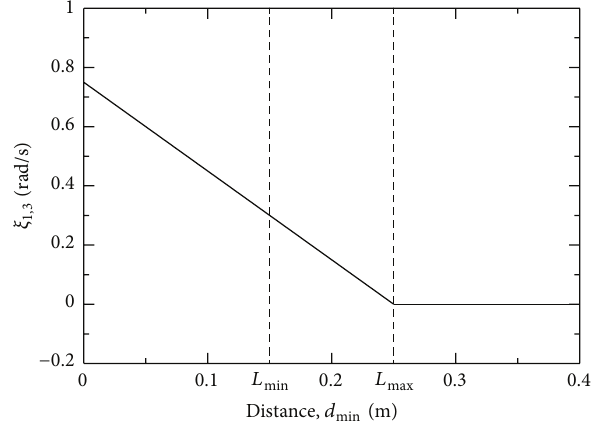
Figure 5: 1st/3rd element of 𝜉 , 𝜉 1,3 .